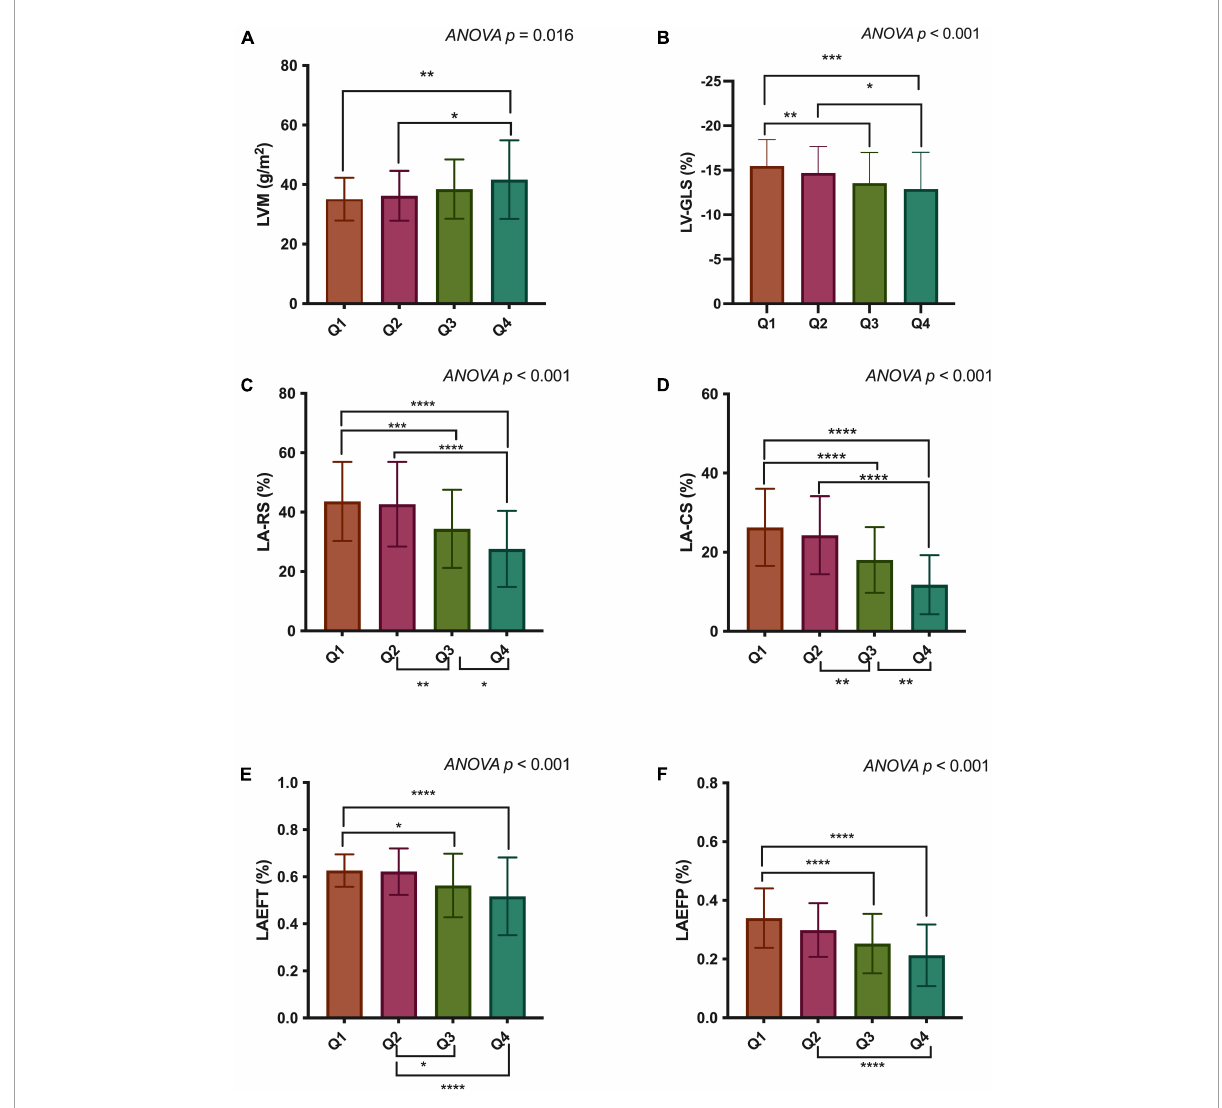
FIGURE3 Comparisons of LVM (A) , LV-GLS (B) , LA-RS (C) , LA-CS (D) , LAEFT (E) , and LAEFP (F) among quartiles of epicardial adipose tissue (EAT) volume. LVM, left ventricular mass; LV-GLS, LV global longitudinal strain; LA-RS, left atrial reservoir strain; LA-CS, LA conduit strain; LAEFT, total LA emptying fraction; LAEFP, passive LA emptying fraction. * p < 0.05; ** p < 0.01, *** p < 0.001; **** p <